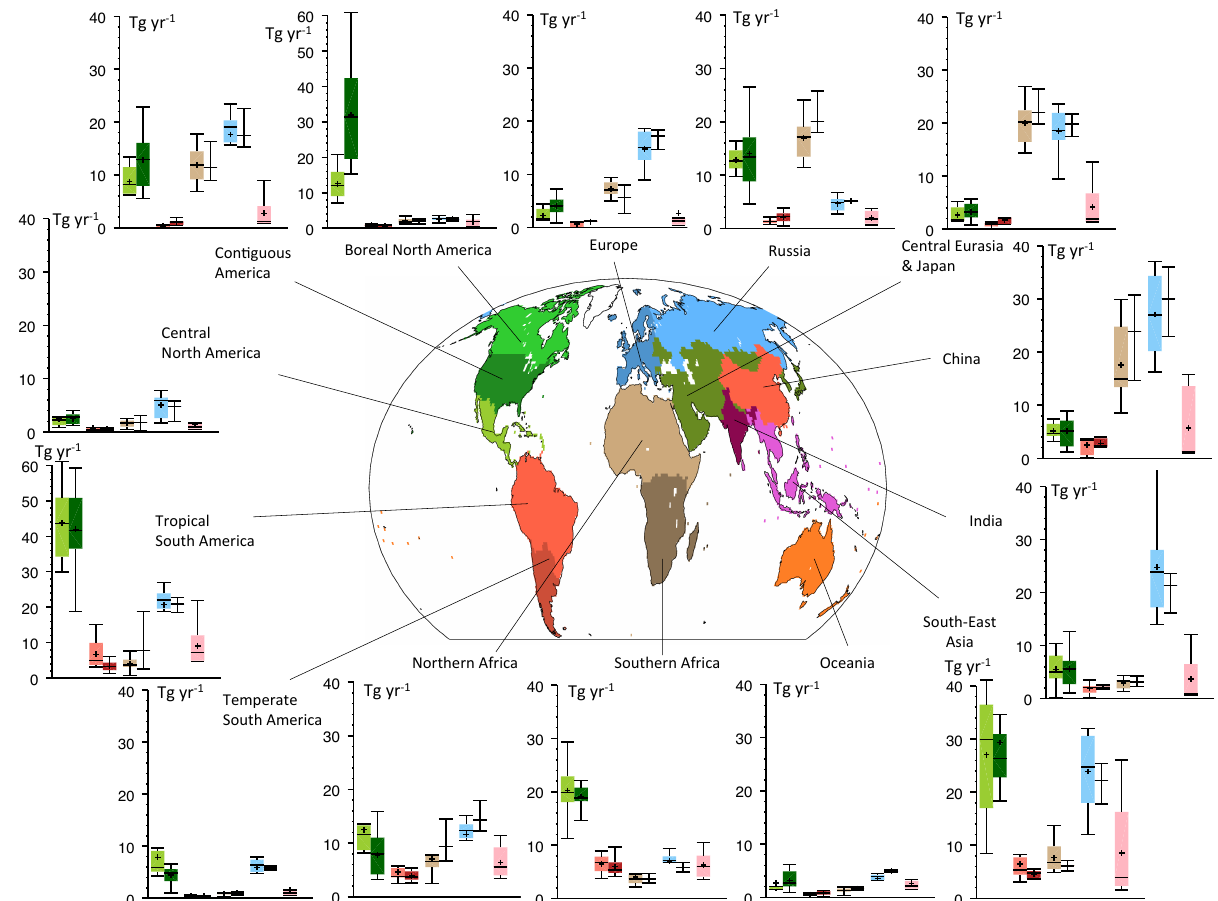
Figure 7. Regional CH 4 budget in TgCH 4 yr − 1 per category (same as for the global emissions in Fig. 6) and map of the 14 continental regions considered in this study. The CH 4 emissions are given for the five categories from left to right (wetlands, biomass burning, fossil fuels, agriculture and waste, and other natural). Top-down estimates are given by the left dark-coloured boxes and bottom-up estimates by the right light-coloured